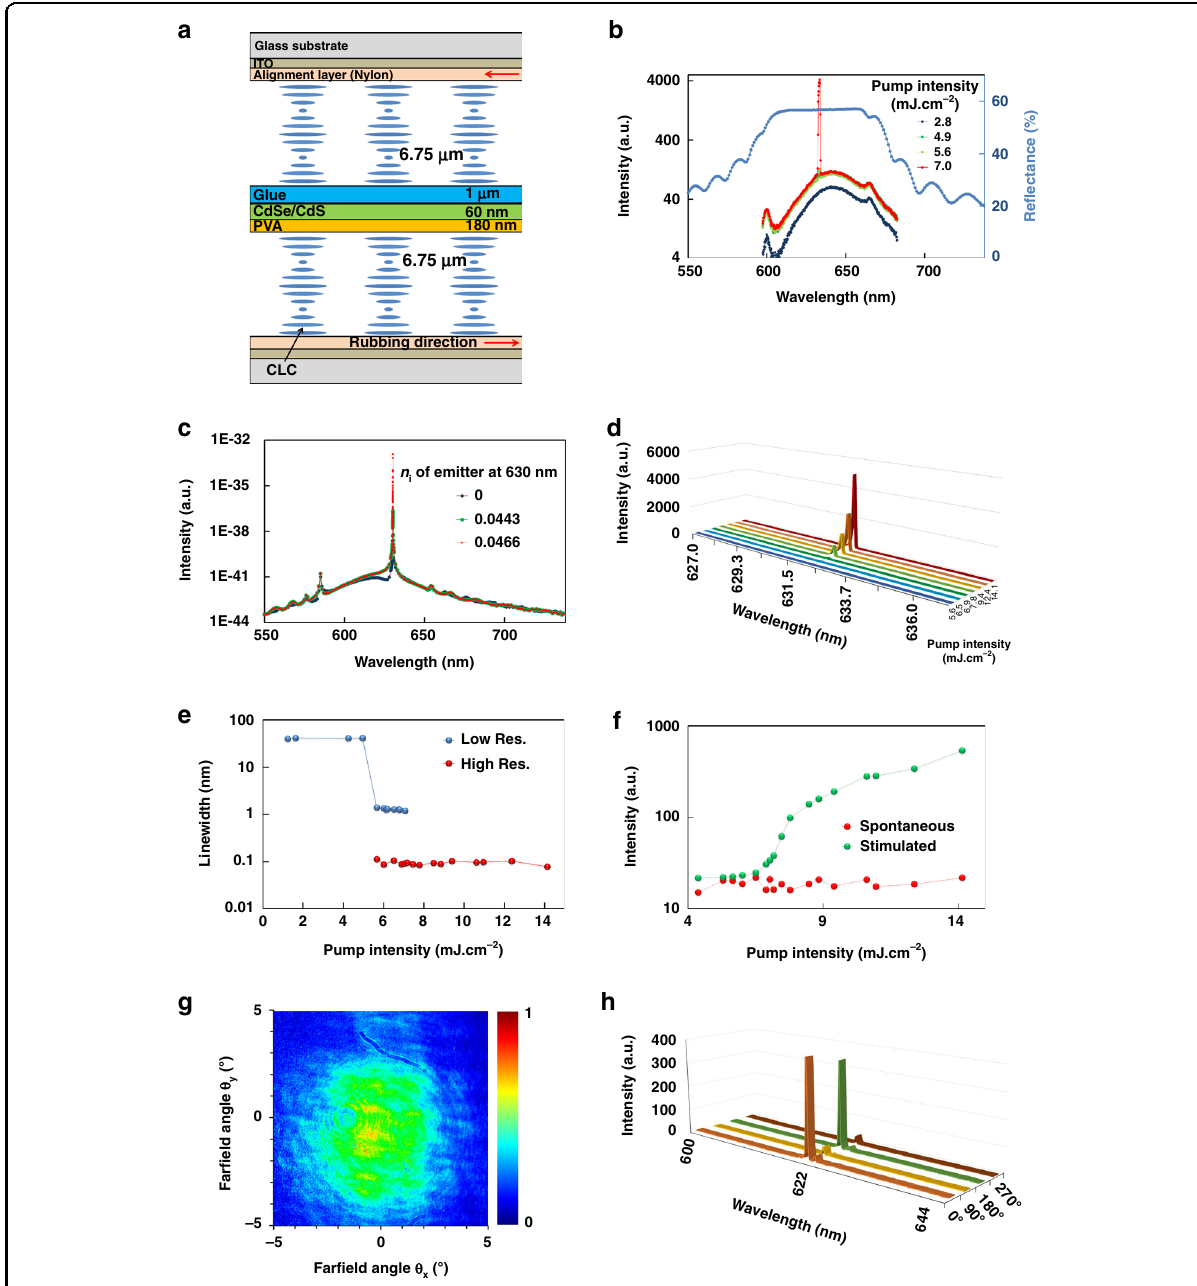
Fig. 2 QDCLC laser structure and characteristics. a Schematic structure of the QDCLC laser. b Measured re fl ection spectrum of the QDCLC layer stack (light blue) and emission spectra for various pump intensities. c Simulated ampli fi ed spontaneous emission spectra for various imaginary parts of refractive index of the QD layer, representing various gain coef fi cients. d Measured high resolution spectra of the QDCLC emission for various pump intensities. e Integrated intensity of the lasing peak (around 632 nm) and of the spontaneous emission (around 650 nm) as a function of the pump intensity. f Linewidth of the measured laser beam, measured with the low (blue dots, as in b ) and high (red dots, as in d , e ) resolution setup, as a function of pump intensity. g Measured intensity of the QDCLC emission as a function of the emission angle. h Integrated emission of the laser peak after transmission through a quarter wave plate and a rotating